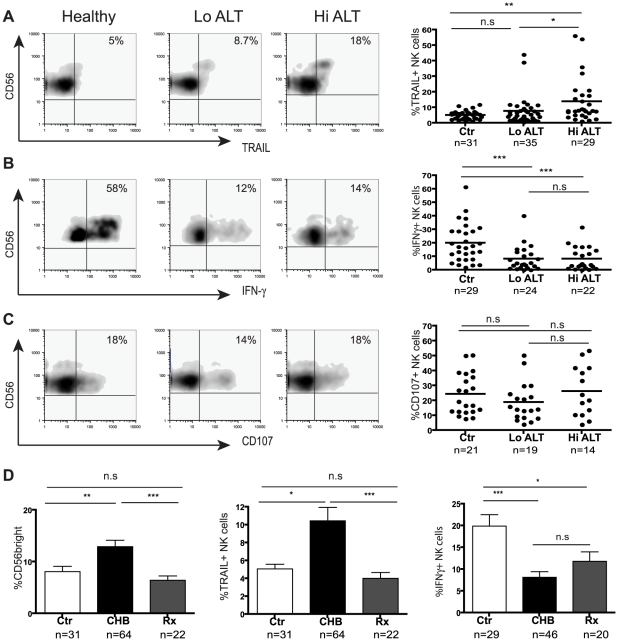
Skewed NK cell effector function in CHB is only partially corrected during therapy.(Panels A–C) Representative density plots from a healthy control and HBV patients with low ALT (ALT <50 IU/L, median 33) and raised ALT (ALT>50 IU/L, median 112) and summary data for TRAIL expression, IFN-γ production and CD107 expression. (D) Summary bar charts of CD56bright proportions, NK cell TRAIL expression and NK cell IFN-γ production from healthy, CHB and patients on antiviral therapy. Results are expressed as mean ± SEM. Rx  =  treated patients. *p<0.05, **p<0.01, ***p<0.001 by Mann-Whitney test.